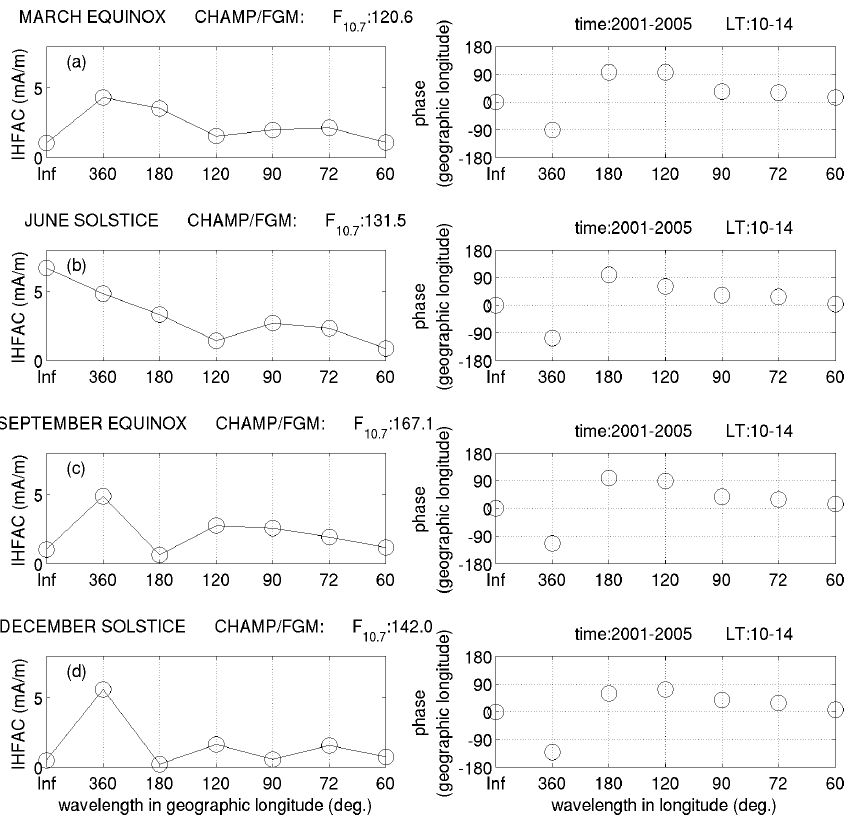
Fig. 4. Amplitude (left column) and phase (right column) spectra of longitudinal variation of IHFACs given in Fig. 3. Each row corresponds to a